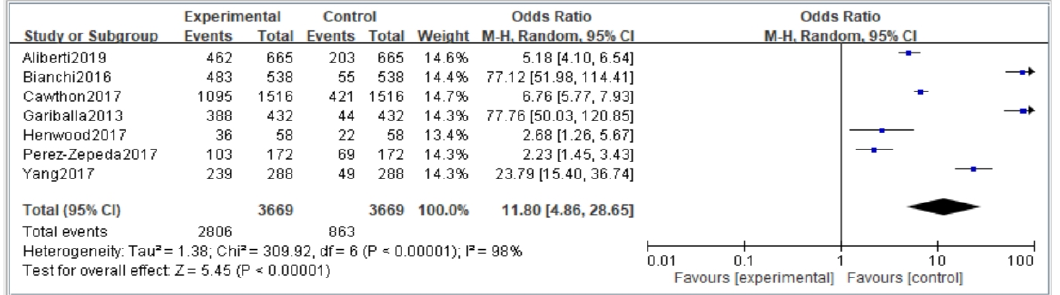
Figure 4. Summary estimates for the sarcopenia status compared to hospitalisation outcome.